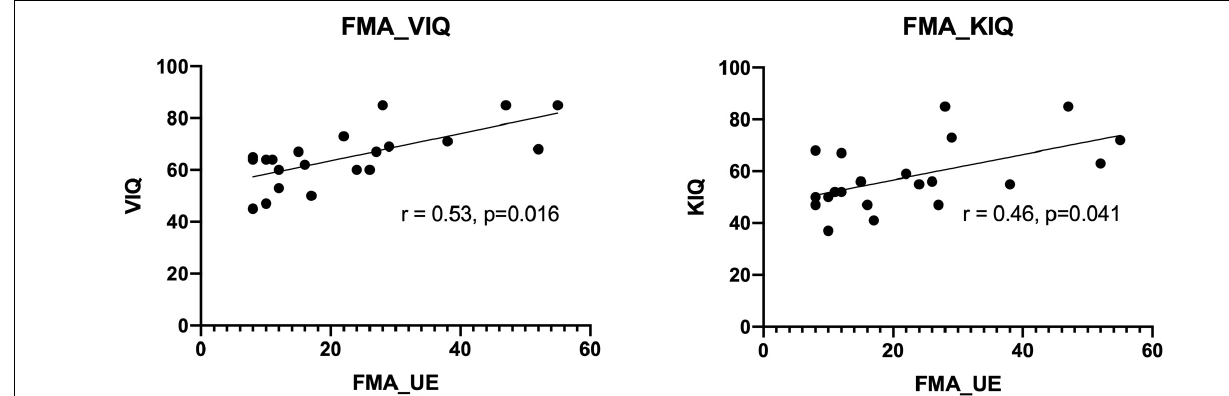
FIGURE 3 | Correlation analyses of KVIQ and FMA-UE scales.